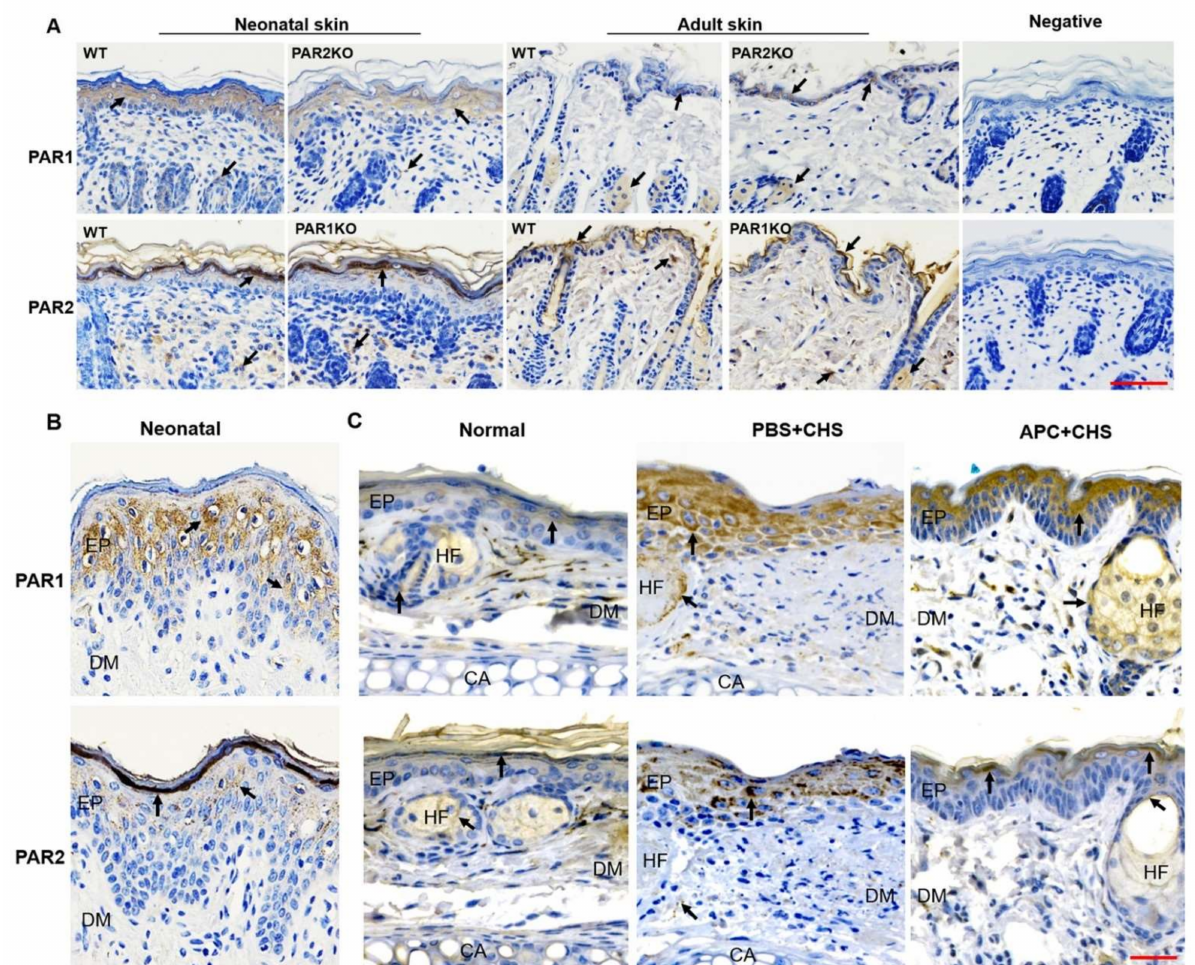
Figure 5. PAR1 and PAR2 expression in skin epidermis. PAR1 and PAR2 in the skin tissues were detected by immunostaining. ( A ) Representative images of PAR1 and PAR2 in skin tissues from newborn or adult WT, PAR1KO or PAR2KO mice. Scale bar: 100 µ m. ( B , C ) Representative images of PAR1 and PAR2 in human neonatal foreskin ( B ), or in the ear skin from normal WT mice or WT mice with CHS treated with APC (2 mg/mL, APC + CHS) or PBS (PBS + CHS). Scale bar: 50 µ m. CA: cartilage; EP: epidermis; DM: dermis; HF: hair follicle. Arrows indicate positive